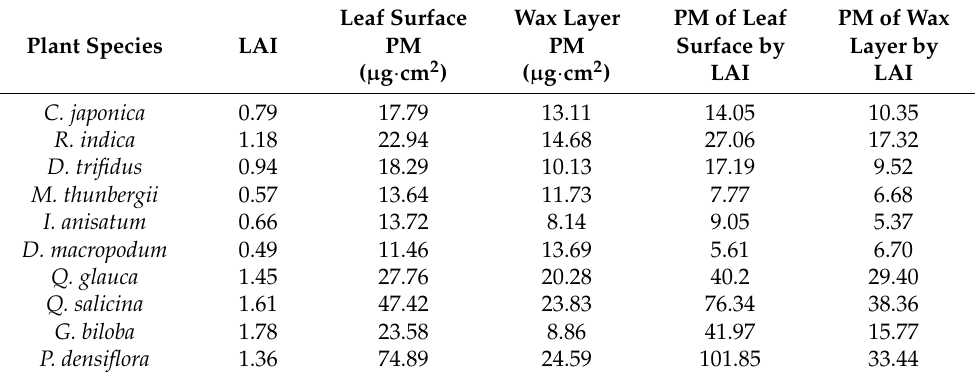
Table 5. PM accumulation amount calculated by LAI as particulate matter (PM) accumulated on the leaf surface and wax layer of 8 evergreen trees and 2